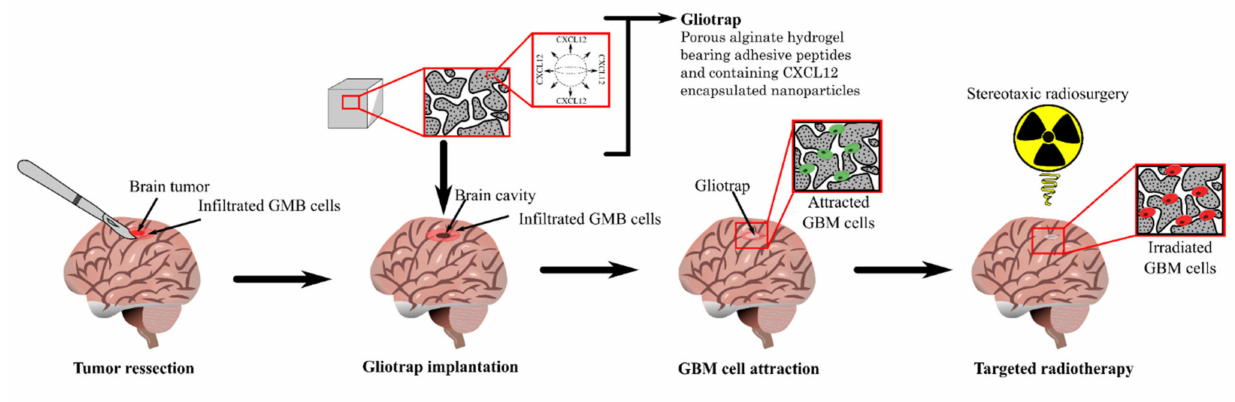
Figure 6. The strategy proposed by our team for GBM